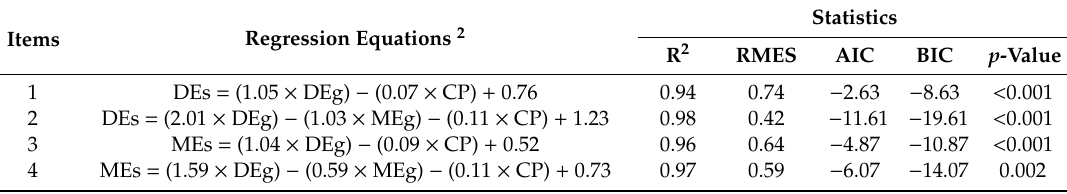
1 DEs, digestibility energy in sows; MEs, metabolizable energy in sows; DEg, digestible energy in growing pigs; MEg, metabolizable energy in growing pigs; DEd, di ff erence between DEs and DEg; MEd, di ff erence between MEs and MEg; GE, gross energy; DM, dry matter; OM, organic matter; CP, crude protein; EE, ether extract; NDF, neutral detergent fiber; ADF, acid detergent fiber. 2 Energy contents were expressed as MJ / kg and chemical compositions were expressed as %. * p < 0.05; ** p < 0.01. Table 8. Prediction equations for digestible energy (DE), and metabolizable energy (ME) for sows in 8 ingredients 1 (dry matter